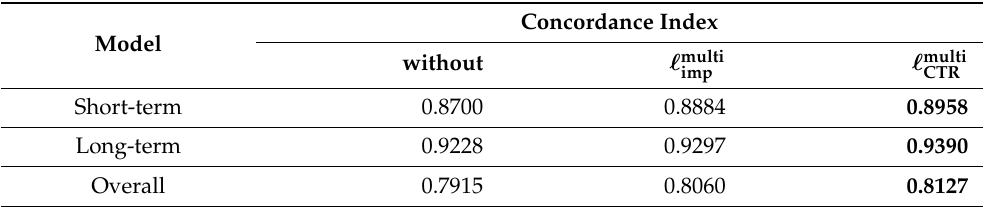
, and (cid:96) multi . imp CTR